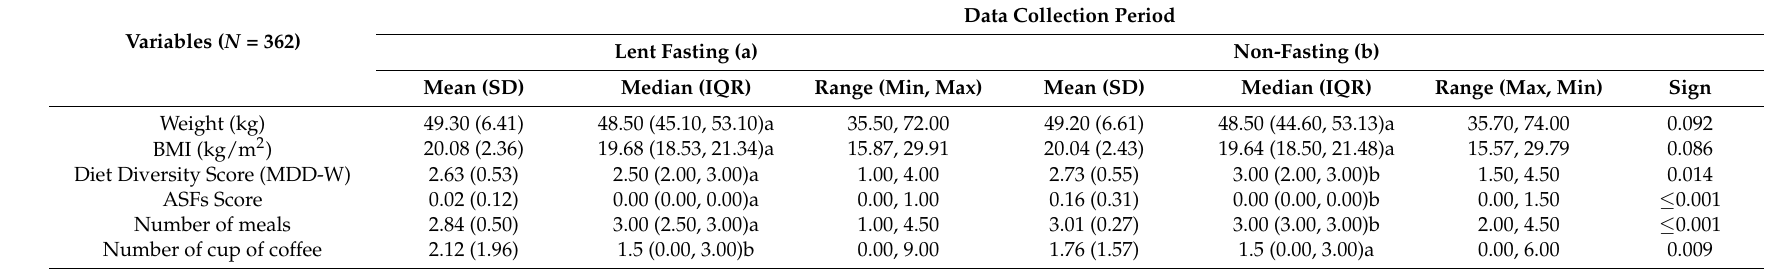
Table 7. Comparison of non-fasting mothers’ food consumption and anthropometric status between Orthodox Lent fasting and non-fasting periods in rural Tigray, Northern